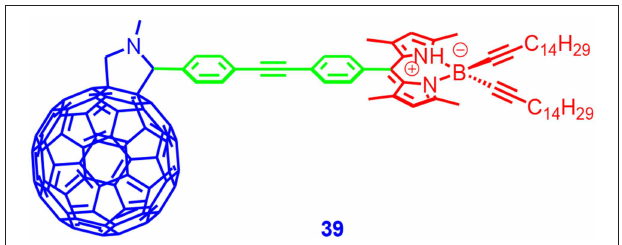
FIGURE 13 | Bodipy–C 60 dyad derivative with Bodipy moiety as electron donor.